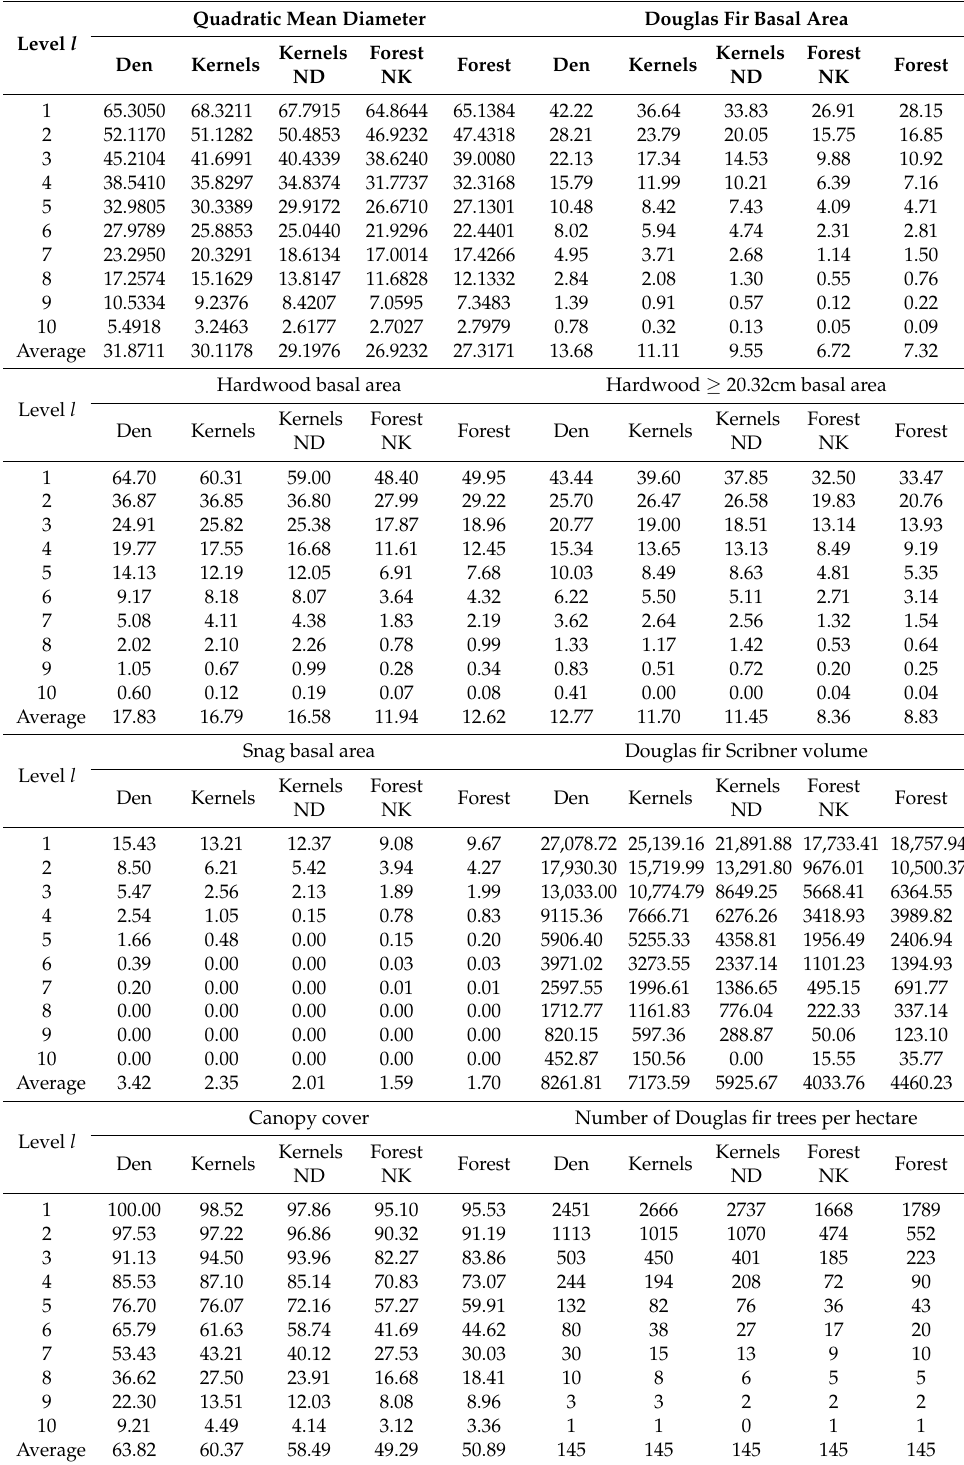
Table 5. Average of attributes over all l levels for each spatial comparison: Den NCs, kernel NCs, kernel NCs excluding dens (Kernels ND), forest excluding kernels (Forest NK), and the